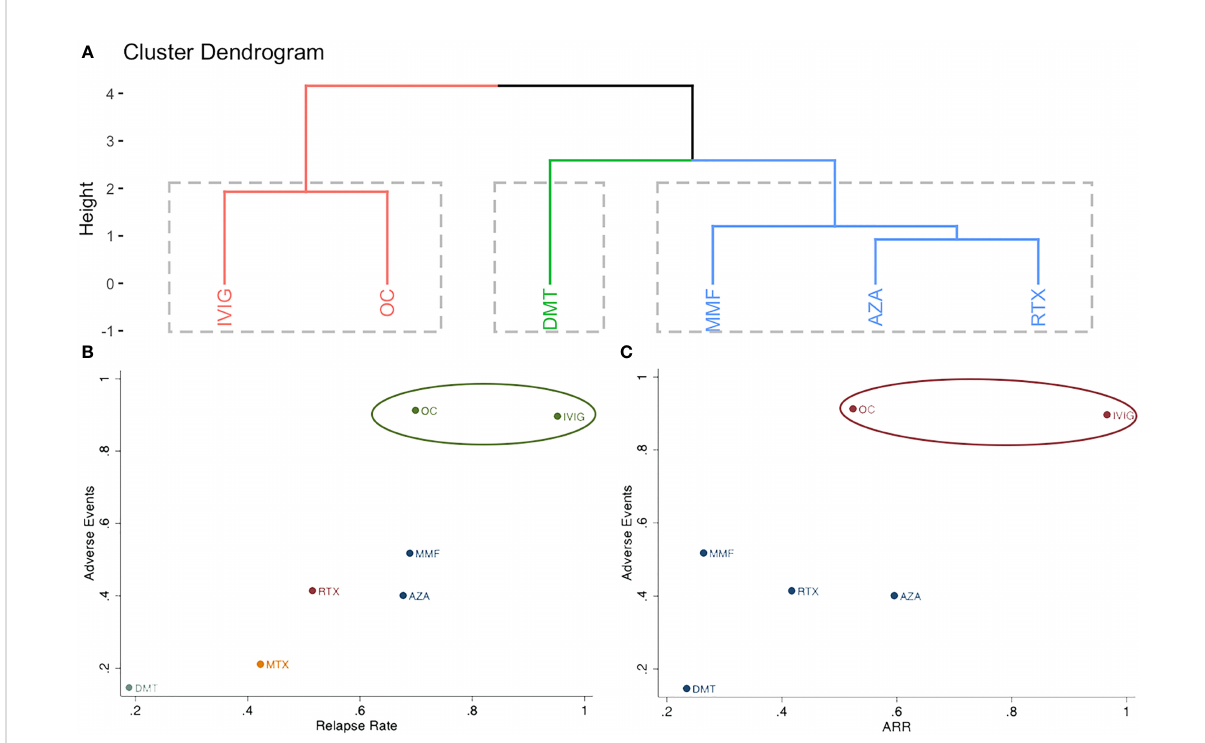
FIGURE 4 Clustering analysis of different treatments for (A) : incidence of relapse, annualized relapse rate and adverse events; (B) : incidence of relapse and adverse events; (C) : annualized relapse rate and adverse